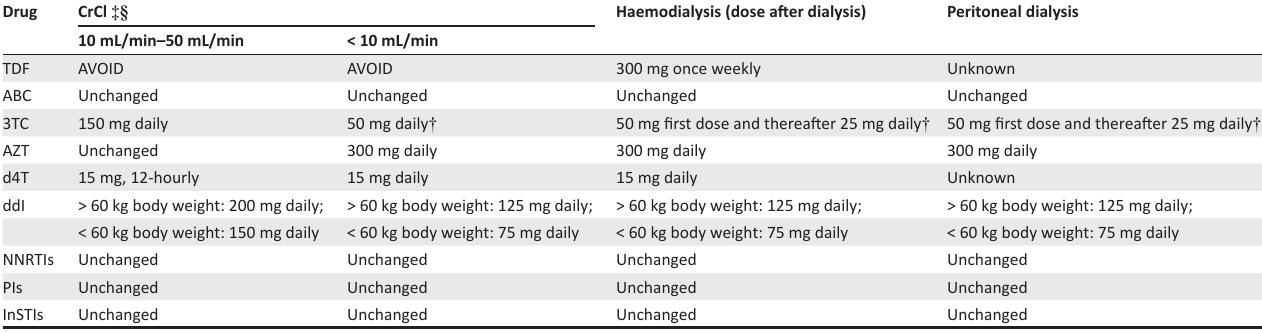
TABLE 11: Antiretroviral drug dosage adjustments in the event of renal failure. Drug Haemodialysis (dose after dialysis) Peritoneal